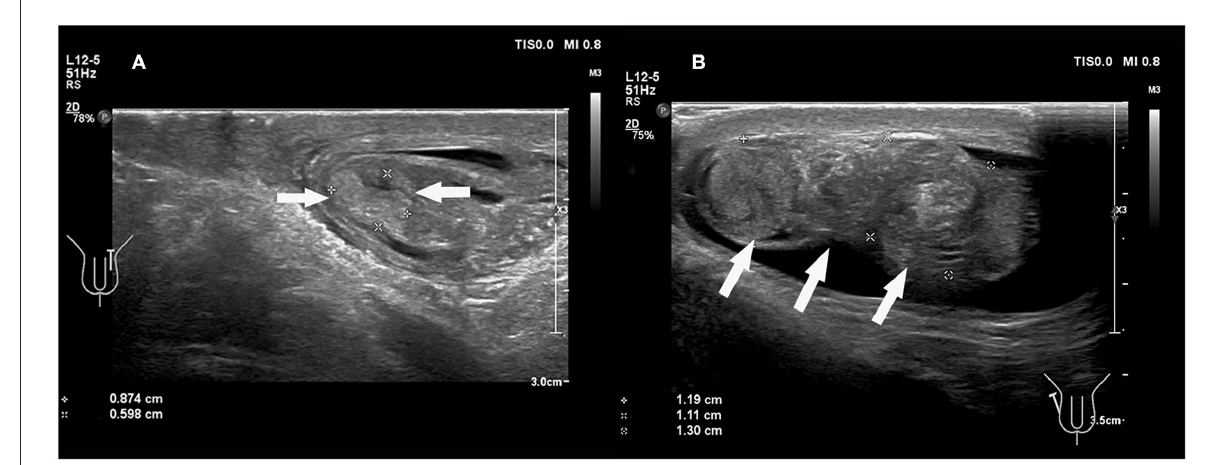
FIGURE5 (A) An 8 years 3-month-old boy with the third episode of acute left scrotal pain for 5 days, initially misdiagnosed as epididymitis. (B) A 14 years, 3-month-old boy with a first episode of acute right scrotal pain for 7h. The conglomerate of edematous epididymis and convoluted spermatic cord (“epididymal-cord complex”), formed pseudomass